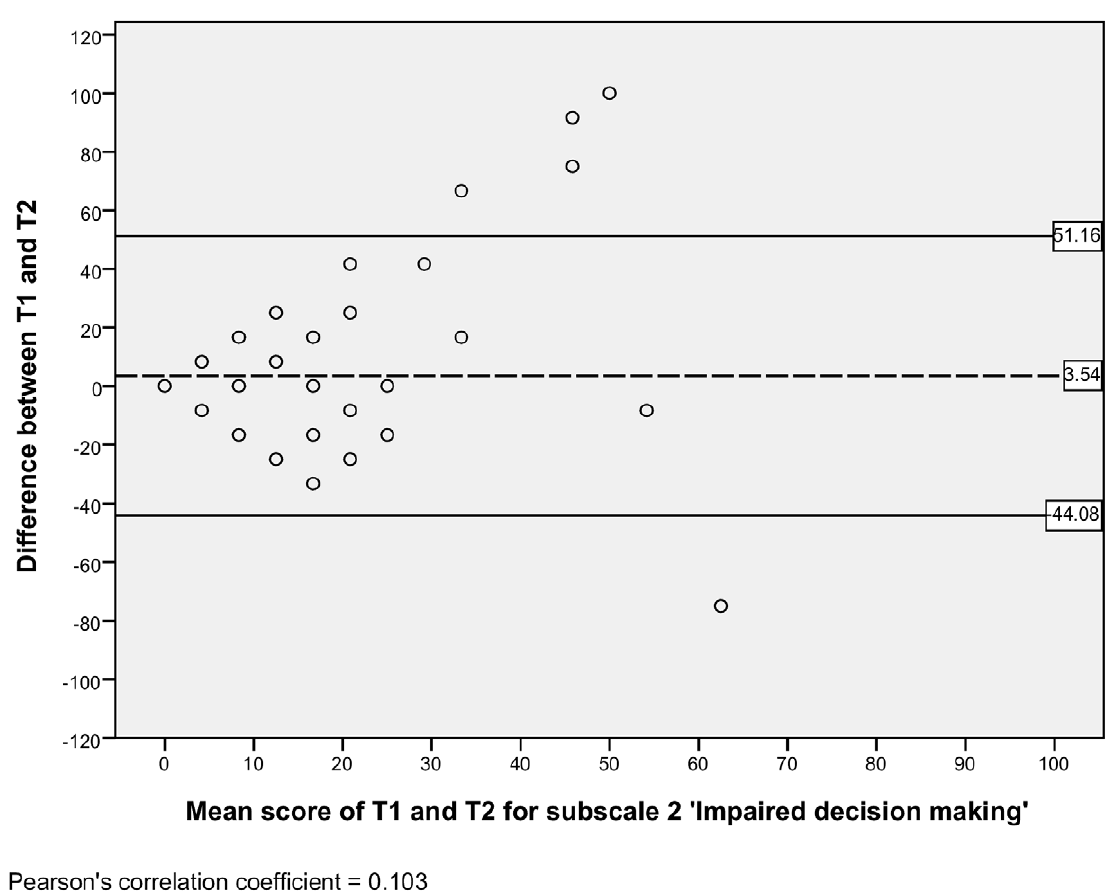
Figure 2. Bland and Altman plot for subscale 2 ‘Impaired decision making’.